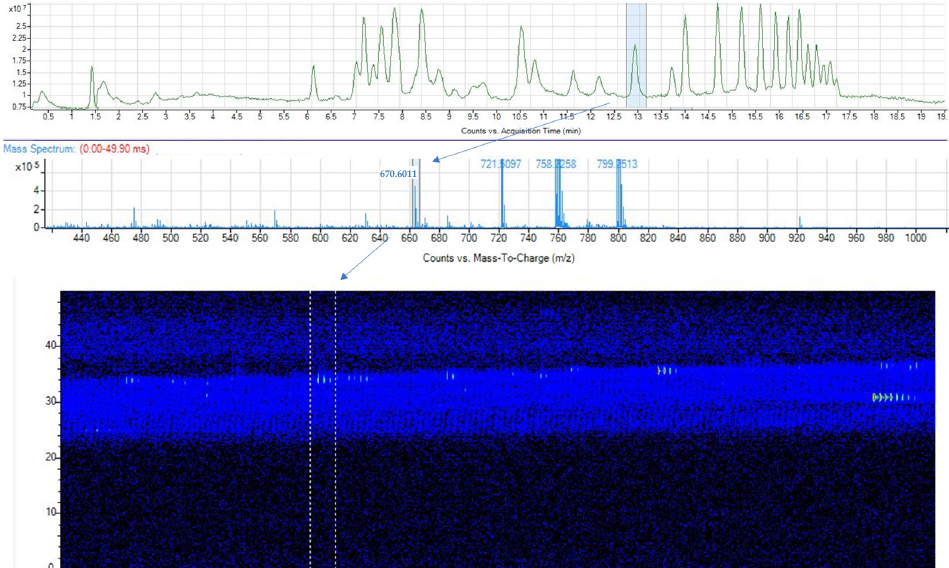
Figure 1. Ion mobility capability to discriminate isomers.